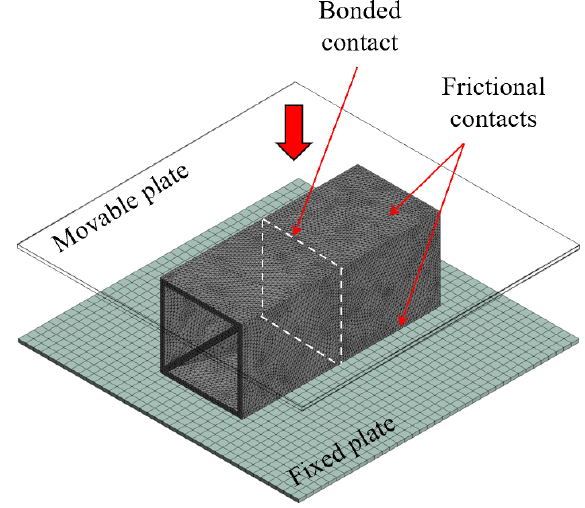
Figure 5. FE model of novel cell under axial load.